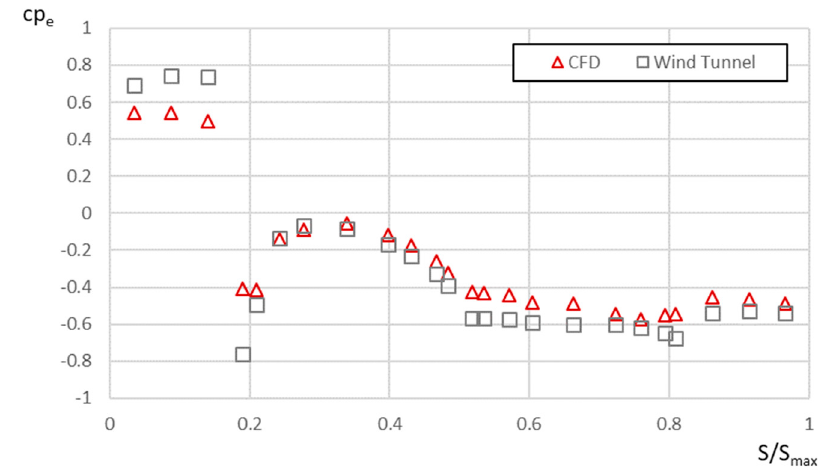
Figure 16. Wind external pressure coefficient values for the 22° even span greenhouse determined by the computational fluid dynamics (CFD) model simulation and the wind tunnel experiments.